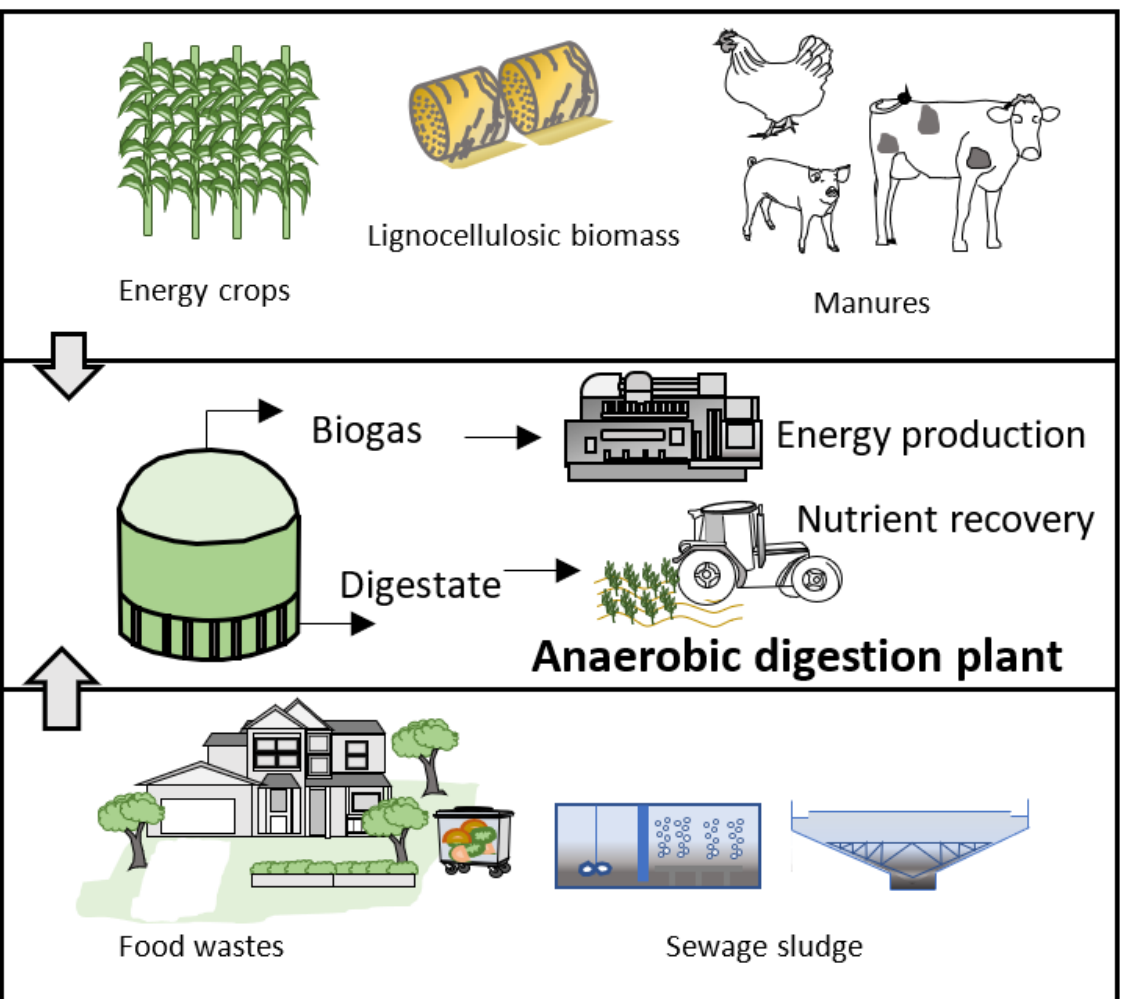
Figure 1. Schematic representation of different substrates suitable for anaerobic co-digestion and valorization of main process products (biogas and digestate).